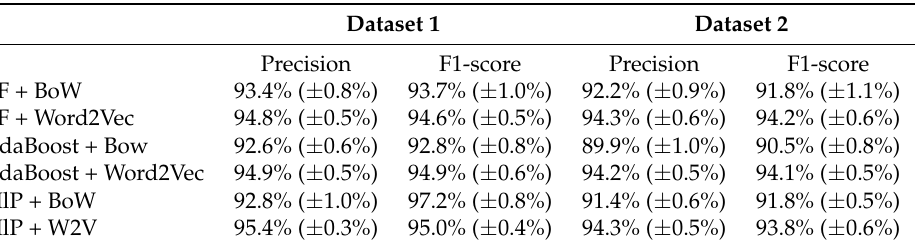
Table 4. Mean cross validation precision and f1-score of the classifiers which predict VAT codes (received invoices). Standard deviation is reported in parentheses.